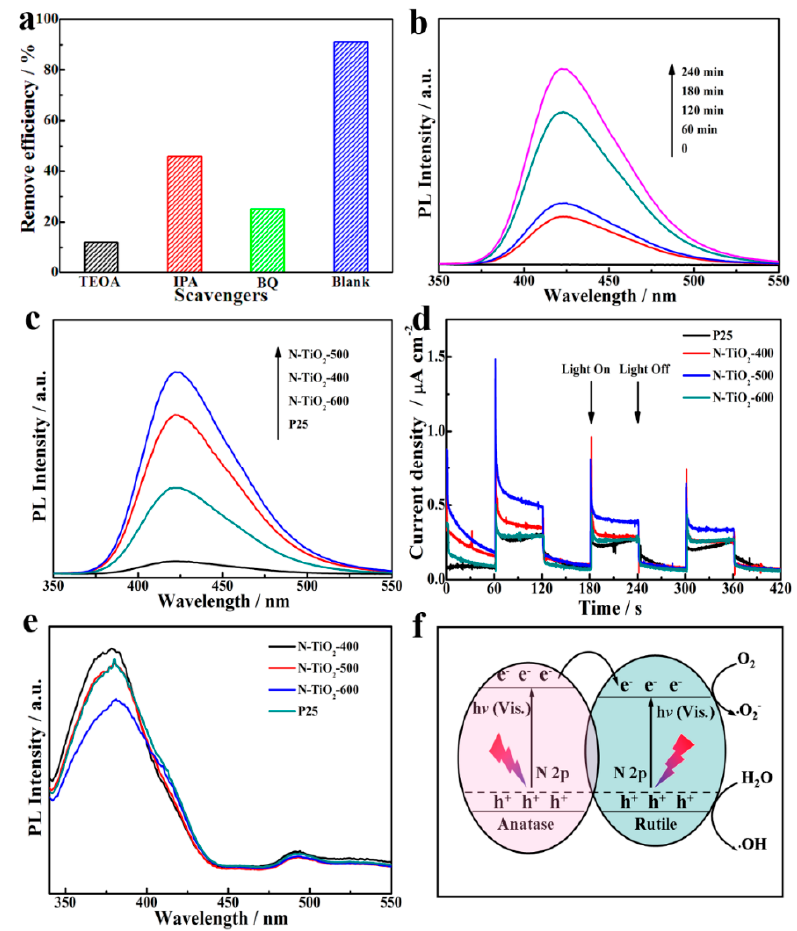
Figure 6. Effects of active species on the photocatalytic degradation efficiencies ( a ), photoluminescence (PL) spectral changes with irradiation time of N-TiO 2 -500 sample in the basic solution of terephthalic acid ( b ), PL spectra of different samples in the basic solution of terephthalic acid after 240 min light irradiation ( c ), transient photocurrent responses ( d ), steady PL spectra of different samples with excitation at 320 nm ( e ), and the possible mechanism for the enhanced photocatalytic activity of N-doped TiO 2 sample ( f ).